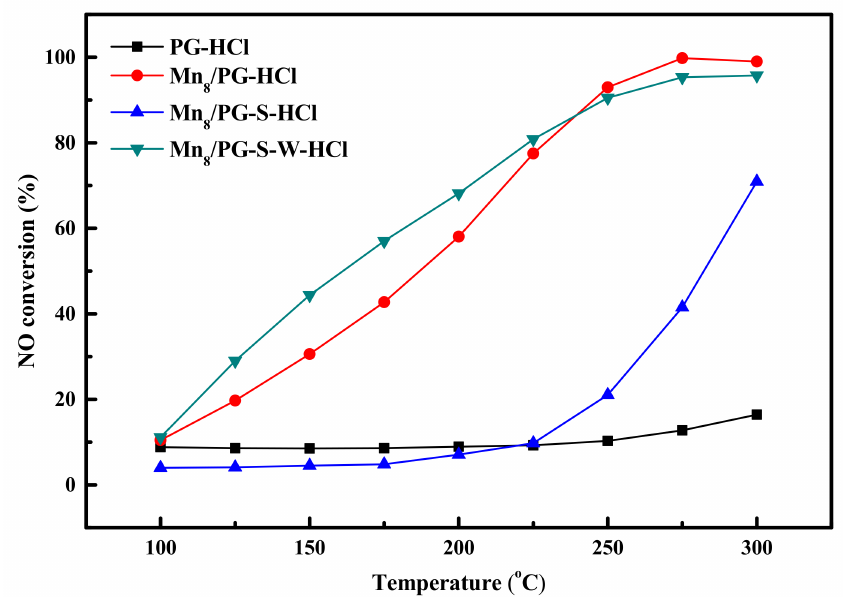
Figure 7. Activity of different HCl-treated, PG-loaded Mn catalysts. Reaction